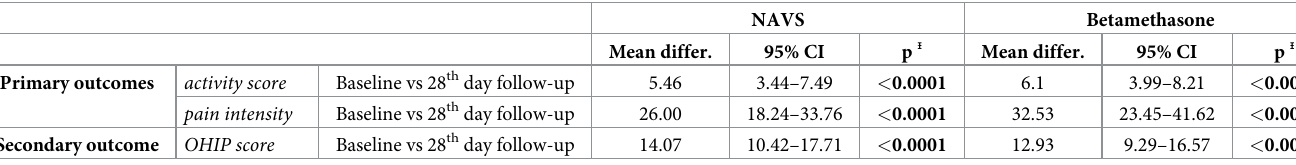
Table 4. Within groups ANOVA—Post-hoc pairwise comparisons (OLP pateints).